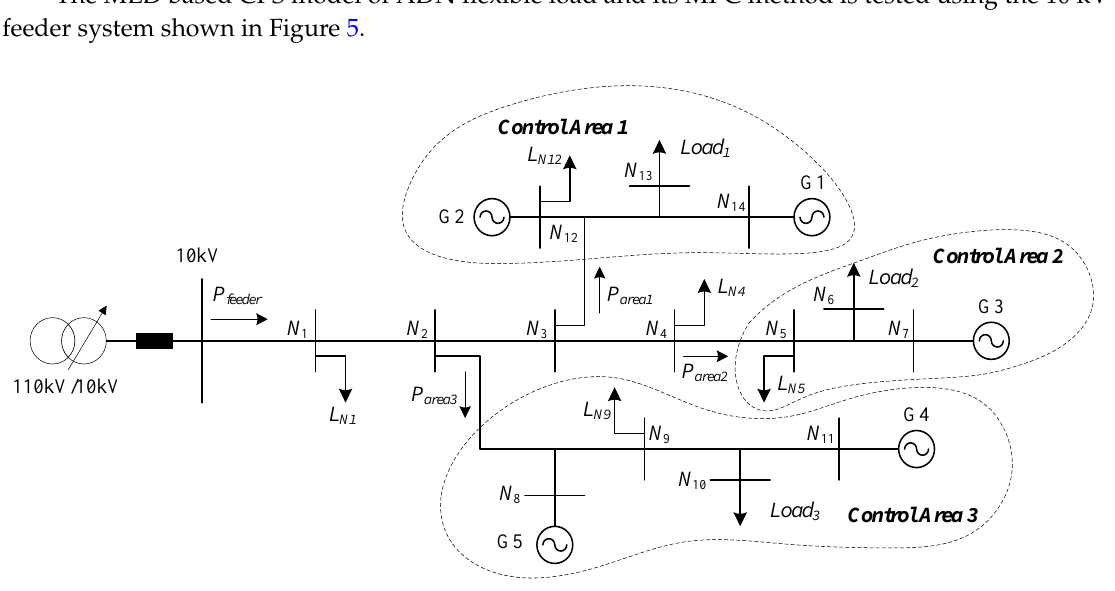
Figure 5. Topological connection of ADN feeder containing flexible load.